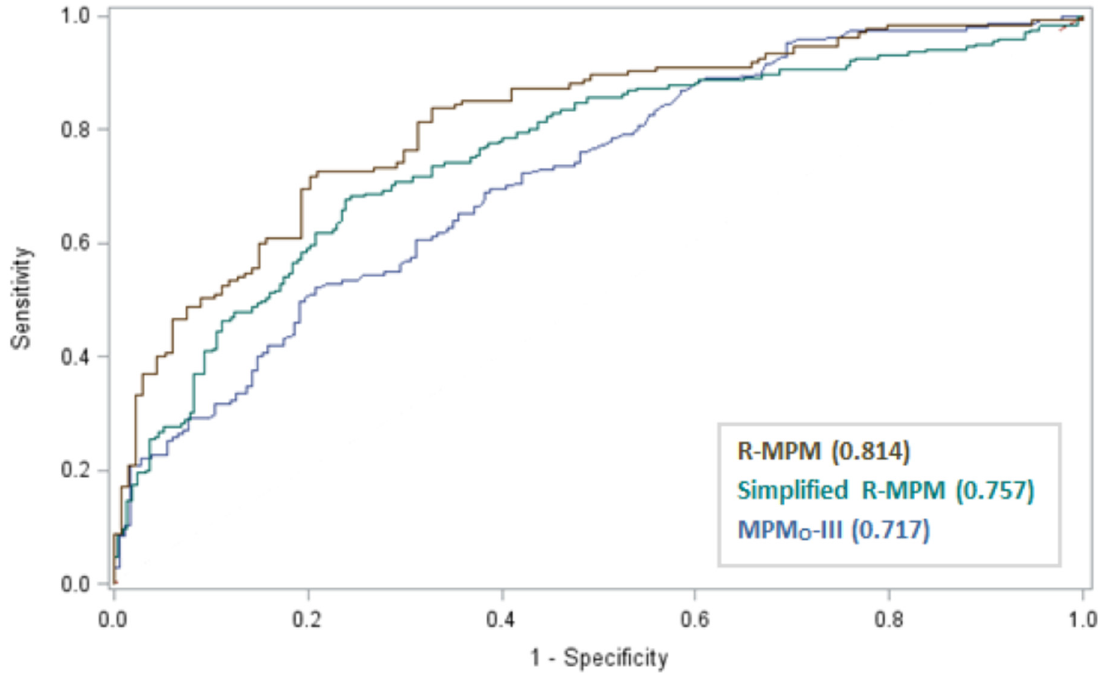
Fig 1. Receiver operating characteristic (ROC) curves for three risk prediction models in a Rwandan ICU population. MPM 0 -III = Mortality Probability Admission Model, version III. R-MPM = Rwanda Mortality Probability Model as detailed in Table 4. Simplified R-MPM = the Rwanda Mortality Probability Model as detailed in Table 4 except that the variable altered mental status replaces the variable Glasgow Coma Scale score. The number in parentheses after each model name in the legend is the area under the ROC curve for that model .